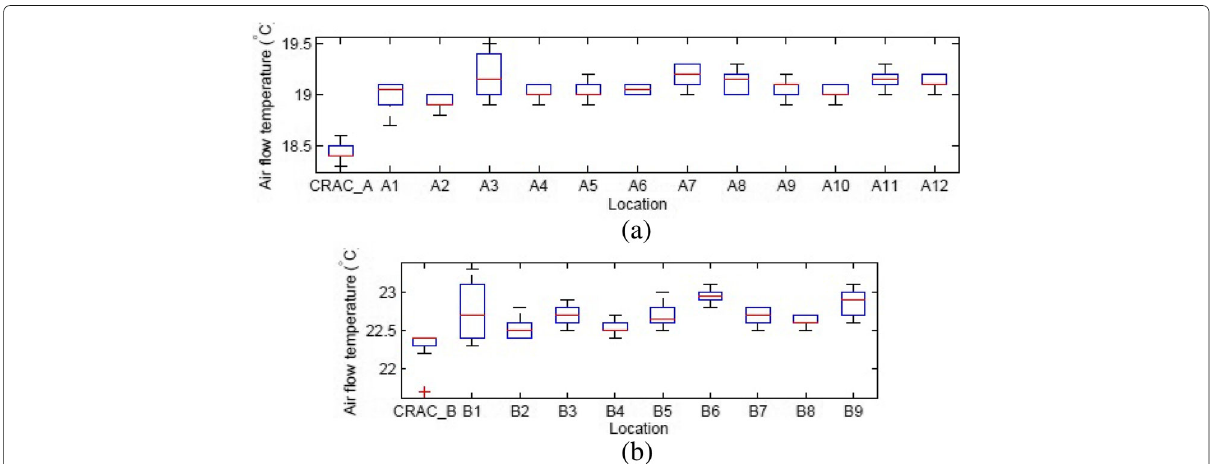
Fig. 5 Measured inlet air flow temperature. a Computer room 1, b Computer room